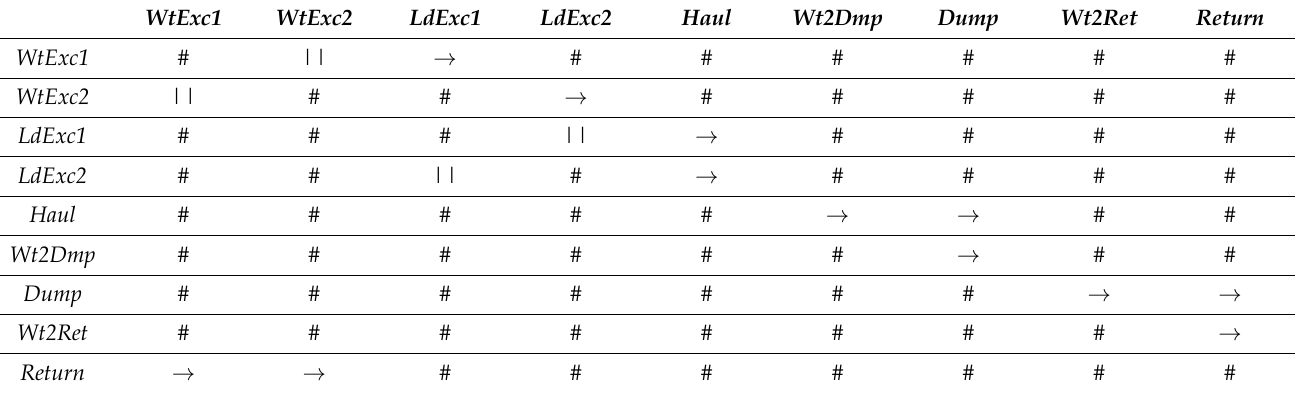
Table 2. Footprint of the event log showing the relationship between